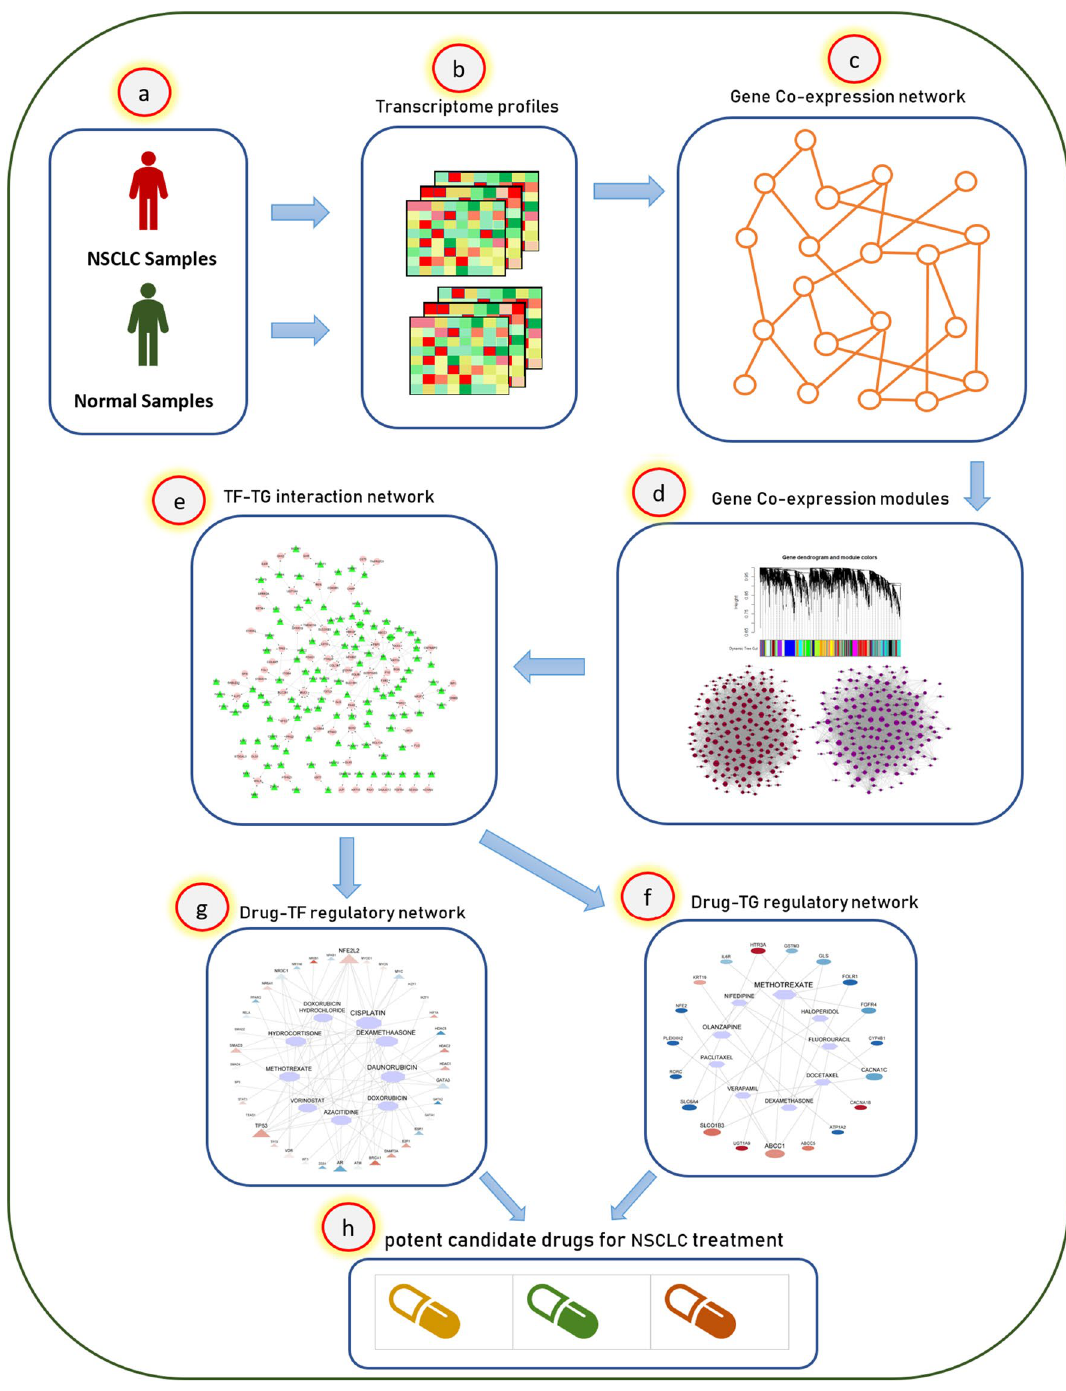
Figure 1. The workflow diagram of the proposed method. This study applies a gene co-expression network and a drug–gene regulatory network analysis to reposition candidate drugs for NSCLC treatment. (a,b) At first, a transcriptome profile for normal and NSCLC samples was downloaded from the GEO database with the accession number GSE21933. (c,d) Then, a gene co-expression network was reconstructed for the differentially expressed genes (p_value < 0.01) of normal and NSCLC groups using the WGCNA package in the R programming environment, and two significant gene modules ( purple and magenta ) were extracted from the NSCLC co-expression network. (e) Next, a list of transcription factor genes, which regulate purple and magenta modules’ genes, were obtained from the Trrust V2.0 40 online database. (f,g) Subsequently, two drug–gene interaction networks, named drug-TG (target gene) and drug-TF (transcription factor gene), were drawn using the DGIdb V4.0 42 online database. (e) Finally, 18 candidate drugs are proposed for NSCLC